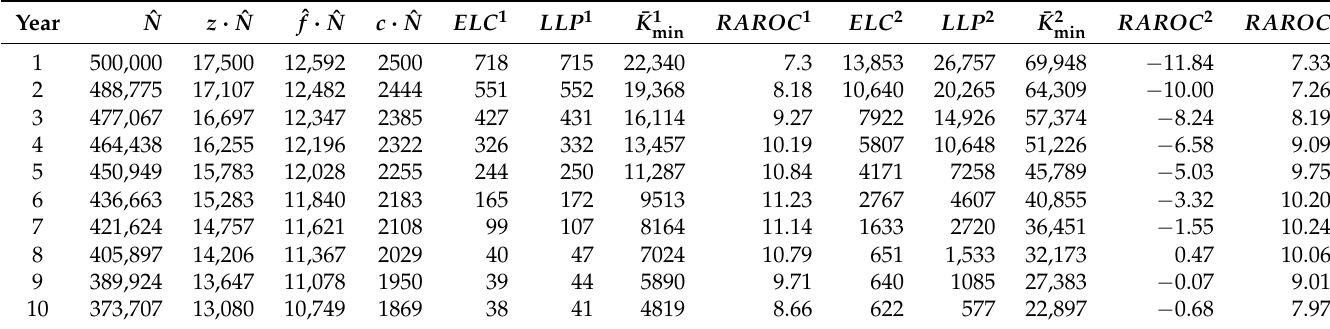
Table 6. Projection of expected loan balance, expected interest income, expected funding costs, expected operational costs, ECL conditional on Stag 1, LLP conditional on Stage 1, adjusted minimum capital conditional on Stage 1, RAROC conditional on Stage 1 (in %), ECL conditional on Stage 2, LLP conditional on Stage 2, adjusted minimum capital conditional on Stage 2, RAROC conditional on Stage 2 (in %), total expected RAROC (in